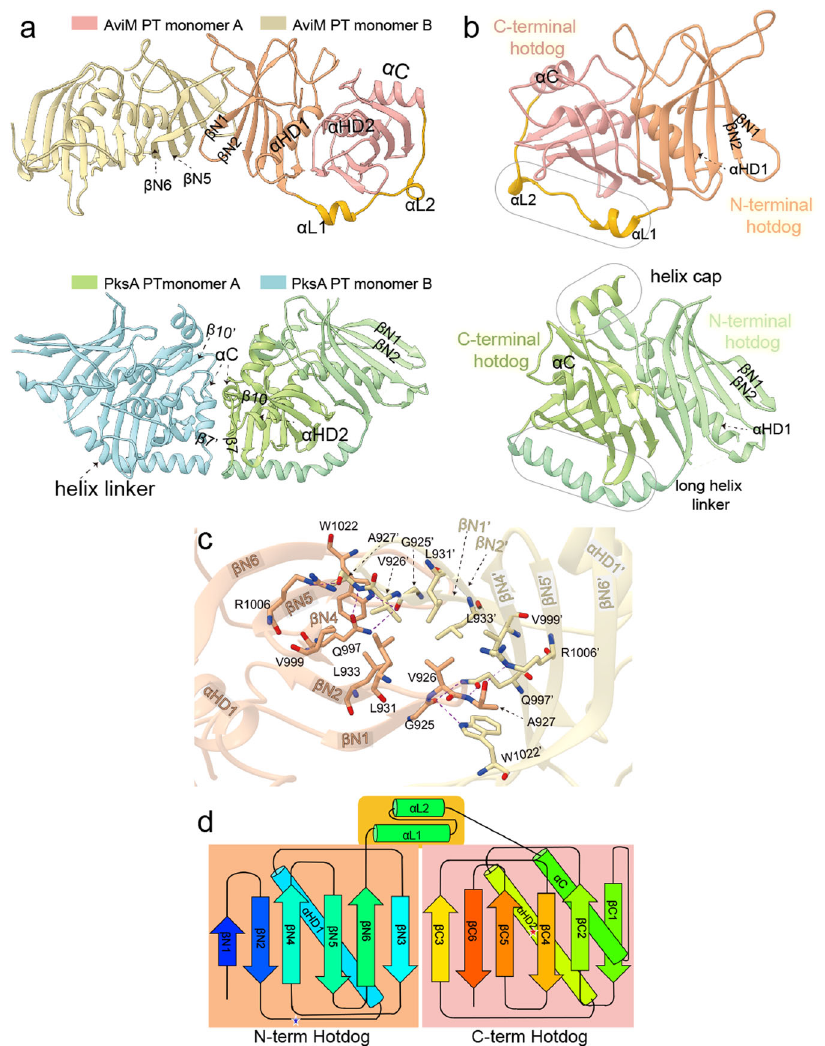
Fig. 3 Overall structure of of AviM PT. a The dimerization interface of AviM PT is different from that of PksA PT (PDB: 5KBZ). The two dimerization interfaces are basically 180° opposite. AviM PT dimerize via N-terminal hotdog while PksA PT dimerizes via C-terminal hotdog. b Differences between AviM PT monomer and PksA PT monomer. Compared to AviM PT monomer, PksA PT monomer contains a bent helix linker, a longer α HD1 helix, longer β 1 and β 2 strands, and a C-terminal helix capping substrate binding tunnel. c Residues located on dimer interface of AviM PT. Hydrogen bonds contributing to dimerization are shown as purple dashed lines. d The topology structure of AviM PT. The monomer has a N-terminal hotdog, a C-terminal hotdog and